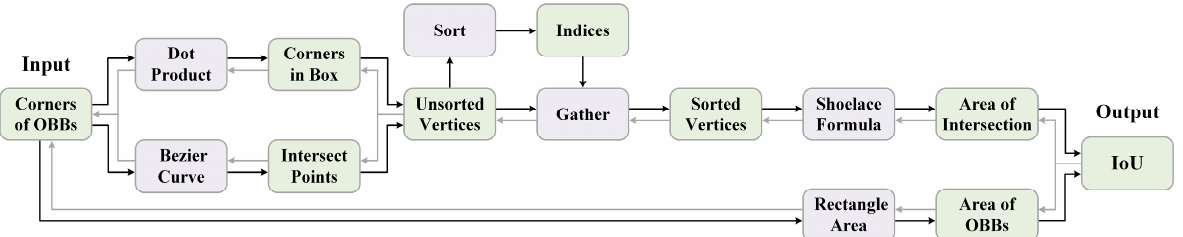
Figure 8. The forward and backward computation of the proposed rotational IoU algorithm. Green and purple boxes signify tensors and operators, respectively. Black and grey arrows indicate forward and backward processes, respectively. Algorithm 1: IoU computation for oriented bounding boxes